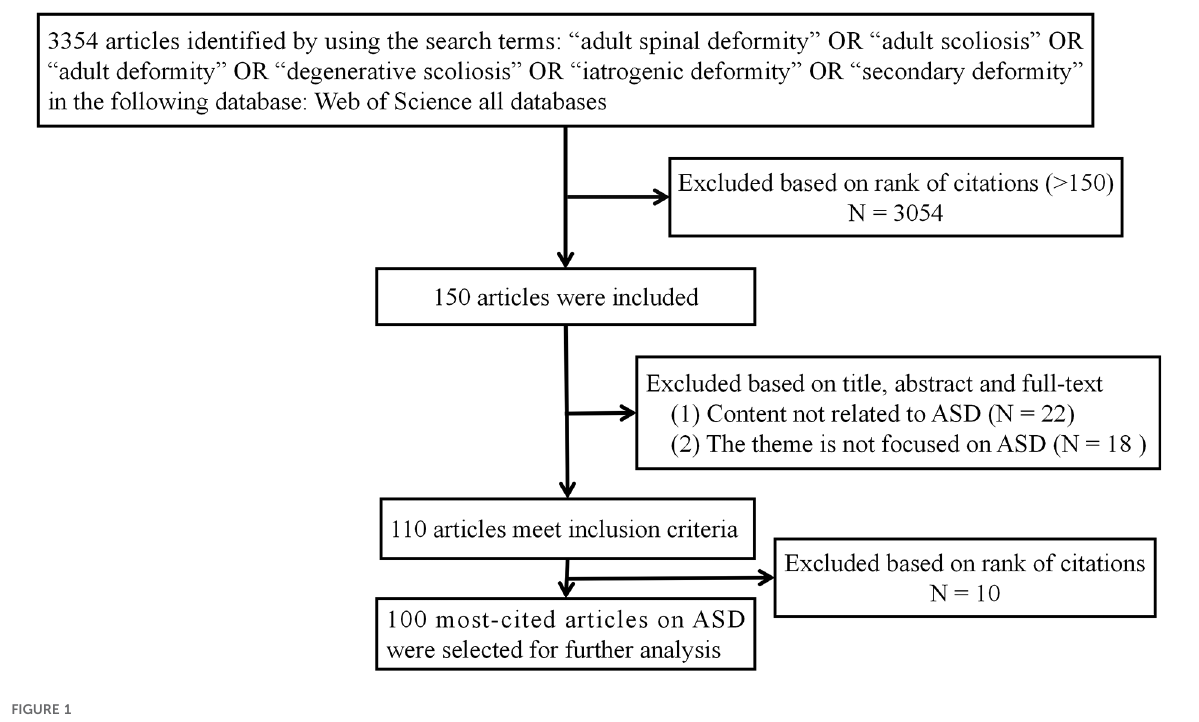
FIGURE 1 Flow diagram of literature search showing studies identi fi ed, included, and excluded at each